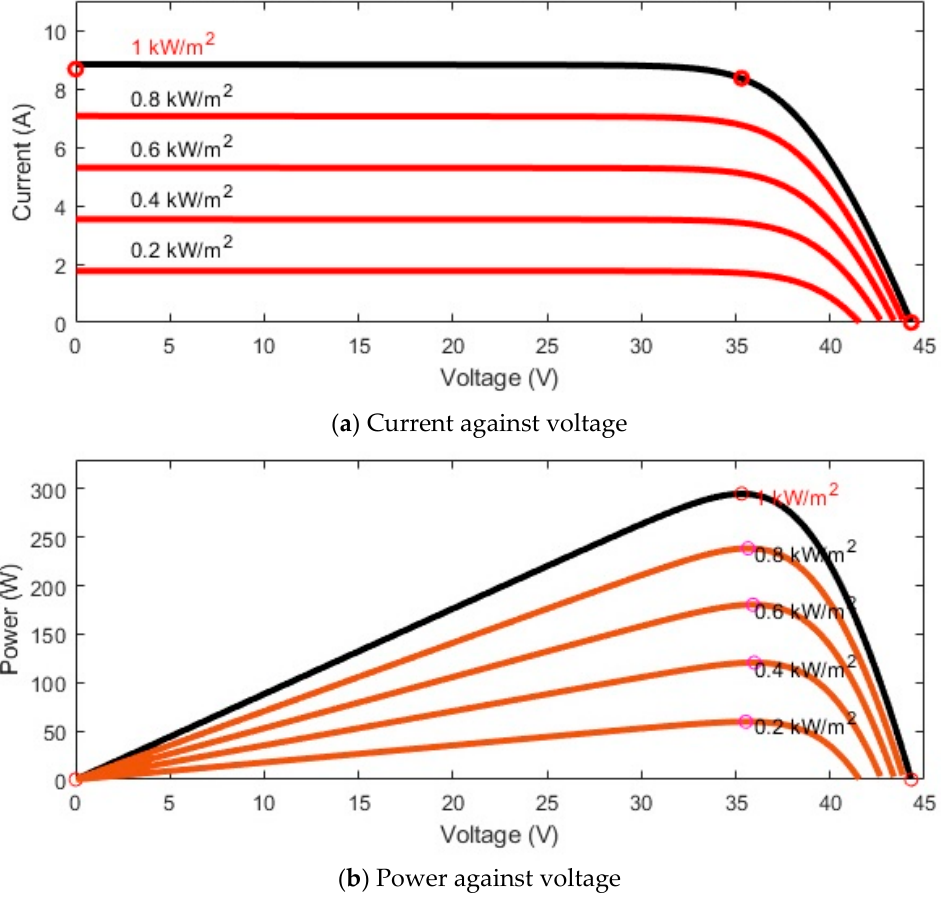
Figure 4. Characteristics of TPB 156x156-72-P-295W PV solar module.